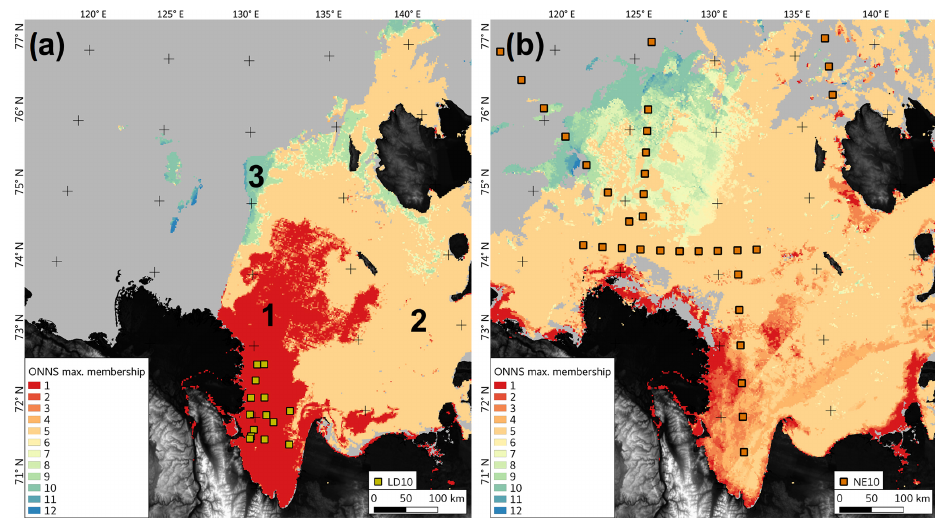
Figure C1. Optical water types from ONNS fuzzy logic classification for (a) average of 3–5 August 2010 and (b) average of 7 and 18– 20 September